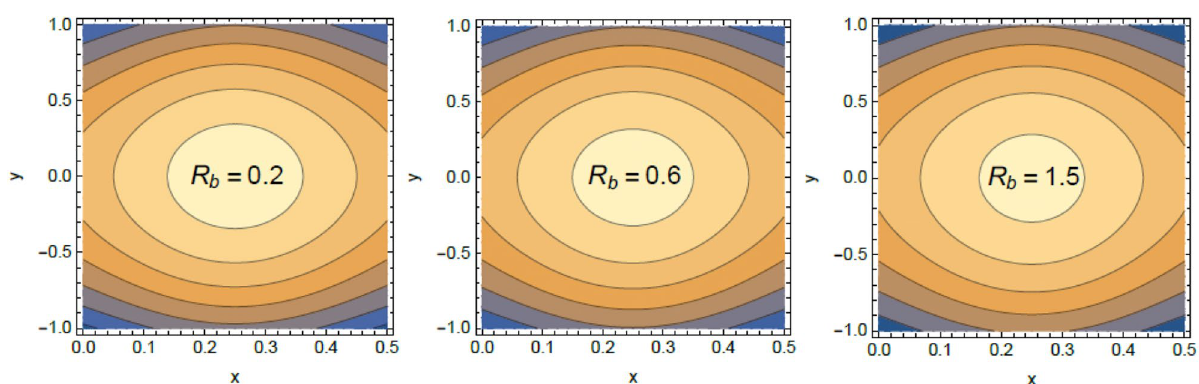
Figure 20. Contour plot of the velocity for several amounts of the bioconvection Rayleigh numeral R b